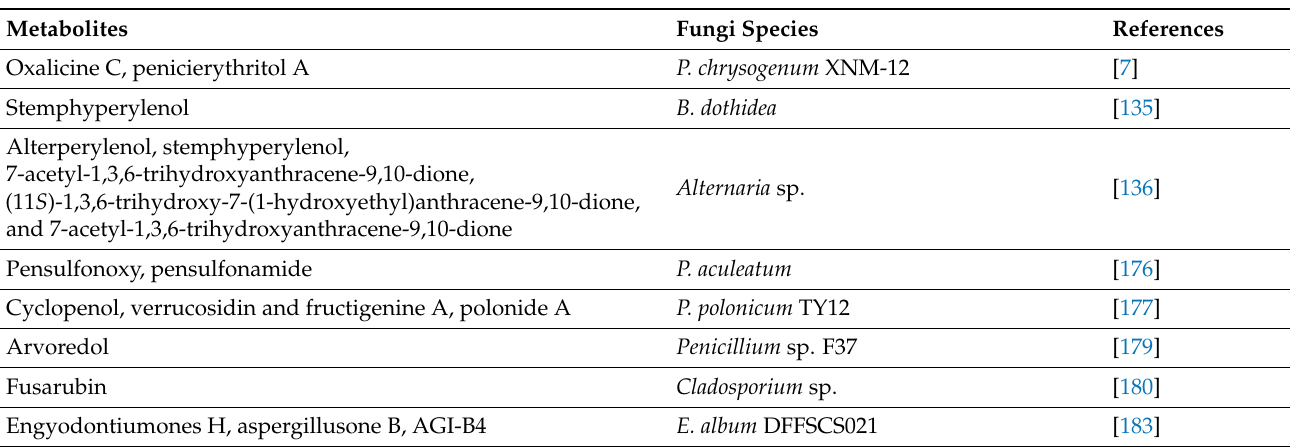
Table 2. Examples of antimicrobial secondary metabolites produced by